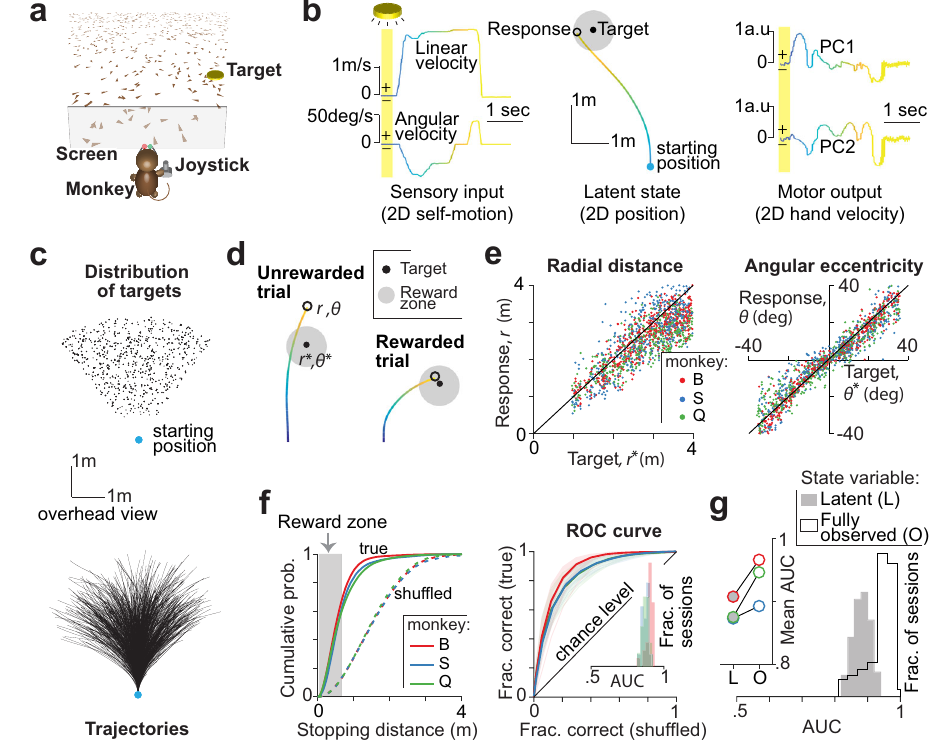
Fig. 1 | Monkeys navigated to a remembered goal by integrating optic fl ow. a Monkeysusedajoystickwithtwodegrees-of-freedomtonavigatetoacuedtarget (yellow disc) using optic fl ow cues generated by ground plane elements (brown triangles) in a virtual environment. b Left: The time course of sensory input vari- ables — linear (top) and angular (bottom) velocities — during one example trial. Middle: Overhead view of the spatialposition of the monkeyduring the trial. Black open circle denotes the monkey ’ s response (stopping location). As there are no visuallandmarks,thepositionbecomeslatenttothemonkeyassoonasthetargetis turned off. Right: Monkey ’ s hand velocity along two leading principal components of hand position, while maneuvering the joystick. Yellow shaded regions corre- spondtothetimeperiod(~300ms)whenthetargetwasvisibleonthescreen.Time is also coded by color. c Top: Overhead view of the spatial distribution of target positions across trials. Bottom: Movement trajectories of one monkey during a representative subset of trials. Blue dot denotes starting location. d Example trials showing “ incorrect ” (left) and “ correct ” (right) responses of a monkey. e Left: Comparison of the radial distance of the response against radial distance of the target across a subset of trials from three different monkeys. Right: Angular eccentricity of the response versus target angle. Black diagonal lines have unity